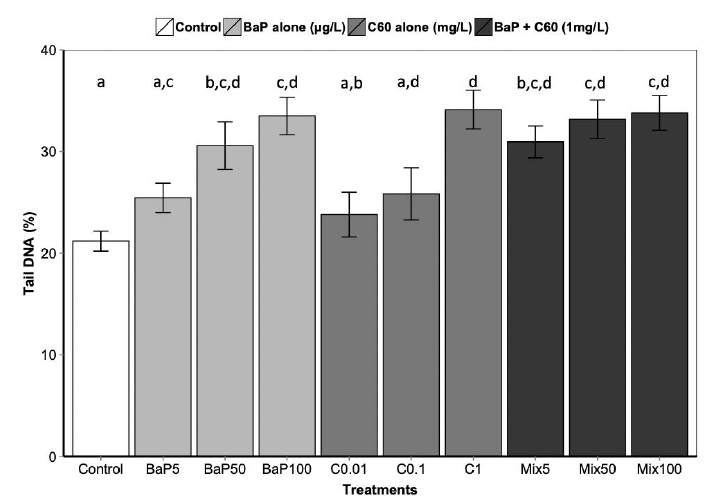
Figure 3. DNA strand break level following 3 days of exposure to C 60 , B[a]P and mixture of both in the digestive gland. Data marked with different letters differed significantly (Tukey post-hoc test; p < 0.05). Table 1. Analysis of combined effects of B[a]P and C 60 on DNA damage based on Interaction Factors (IF).